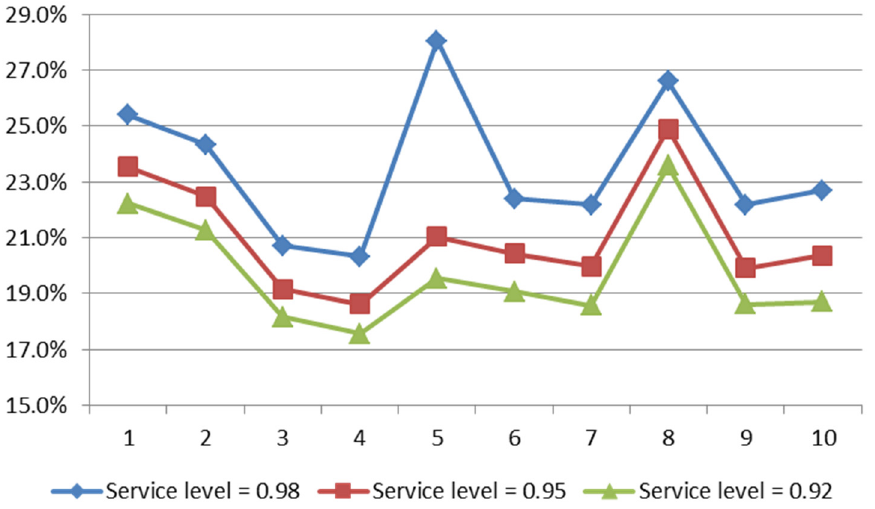
Figure 7. Total replenishment cost reduction percentage of the system by adding PDCs.